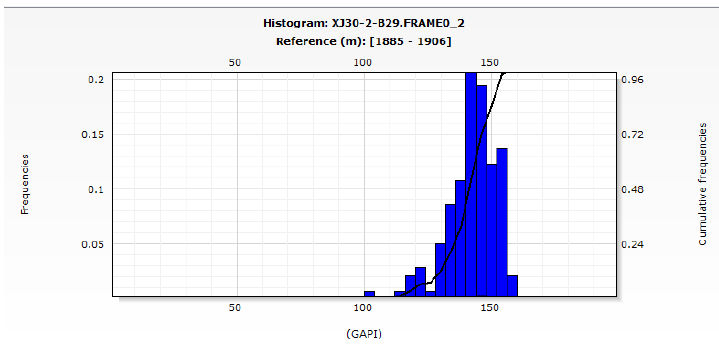
Fig. 4 GR distribution histogram of standard well in upper mudstone layer of